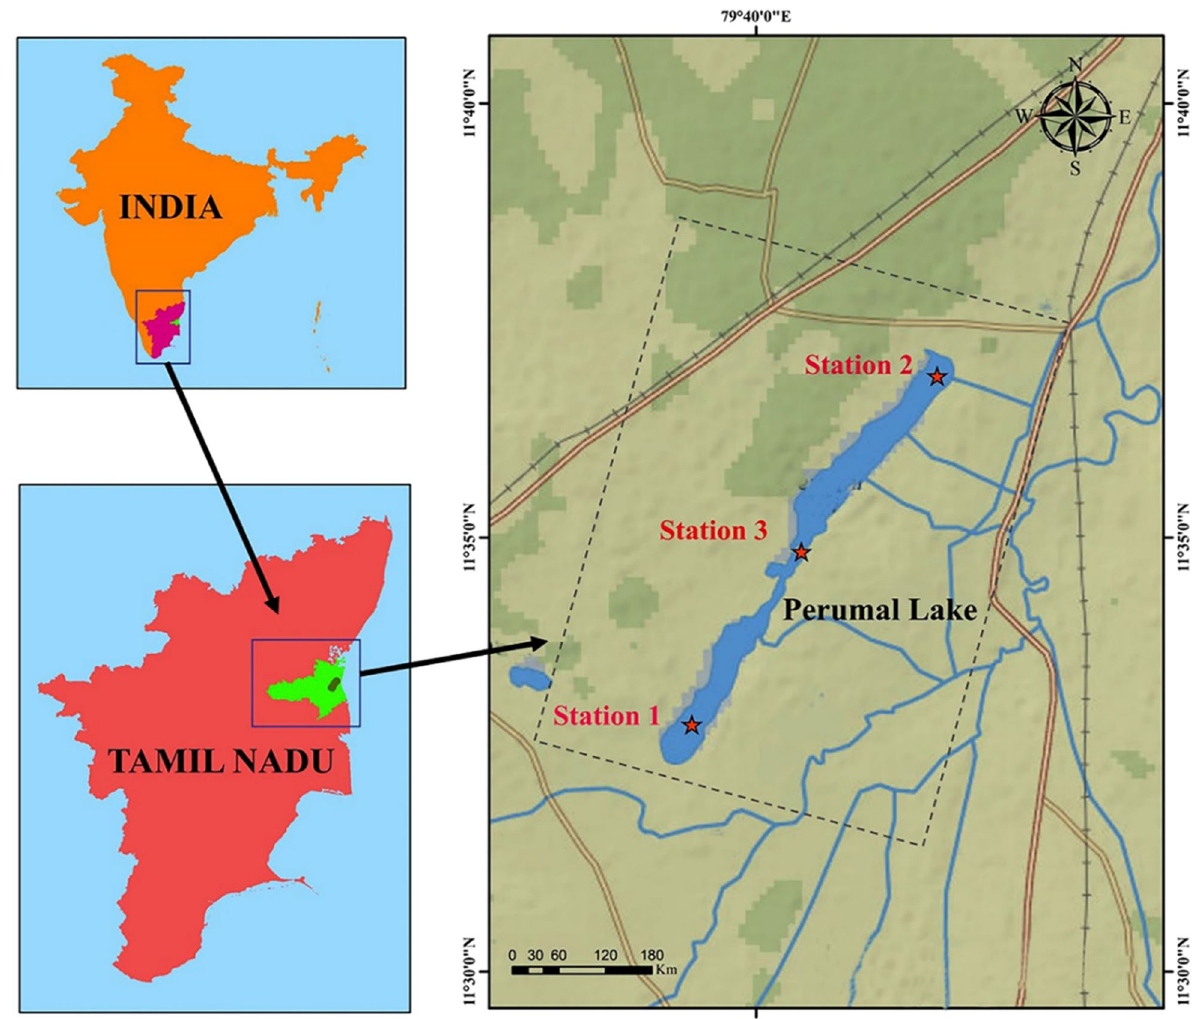
Fig. 1 Map showing the study area of Perumal Lake (Cuddalore District, Tamil Nadu,